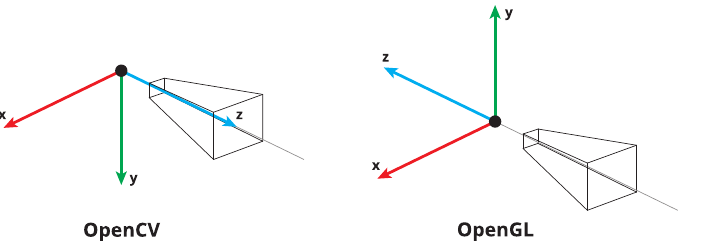
Figure A1. Conversion between coordinate systems: In OpenCV, the camera looks along the positive z -axis and the y -axis points downward. In OpenGL, the camera looks along the negative z -axis, and the y -axis points